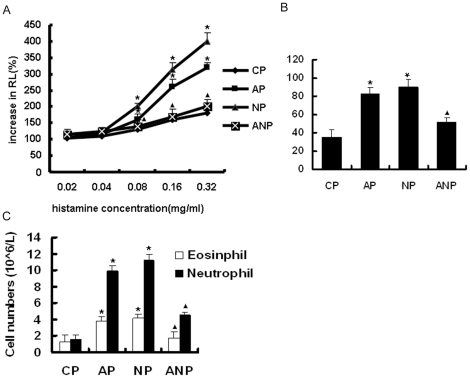
The changes of airway resistance (RL) and the cell counts in the BALF
of maternal rats.
A: RL in maternal rats. B: The total cell
counts in the BALF of maternal rats. C: The number of neutrophils and
eosinophils in BALF of maternal rats. The values are means ± SEM
(n = 8); * P<0.05 vs. CP,
▴<0.05 vs. AP.